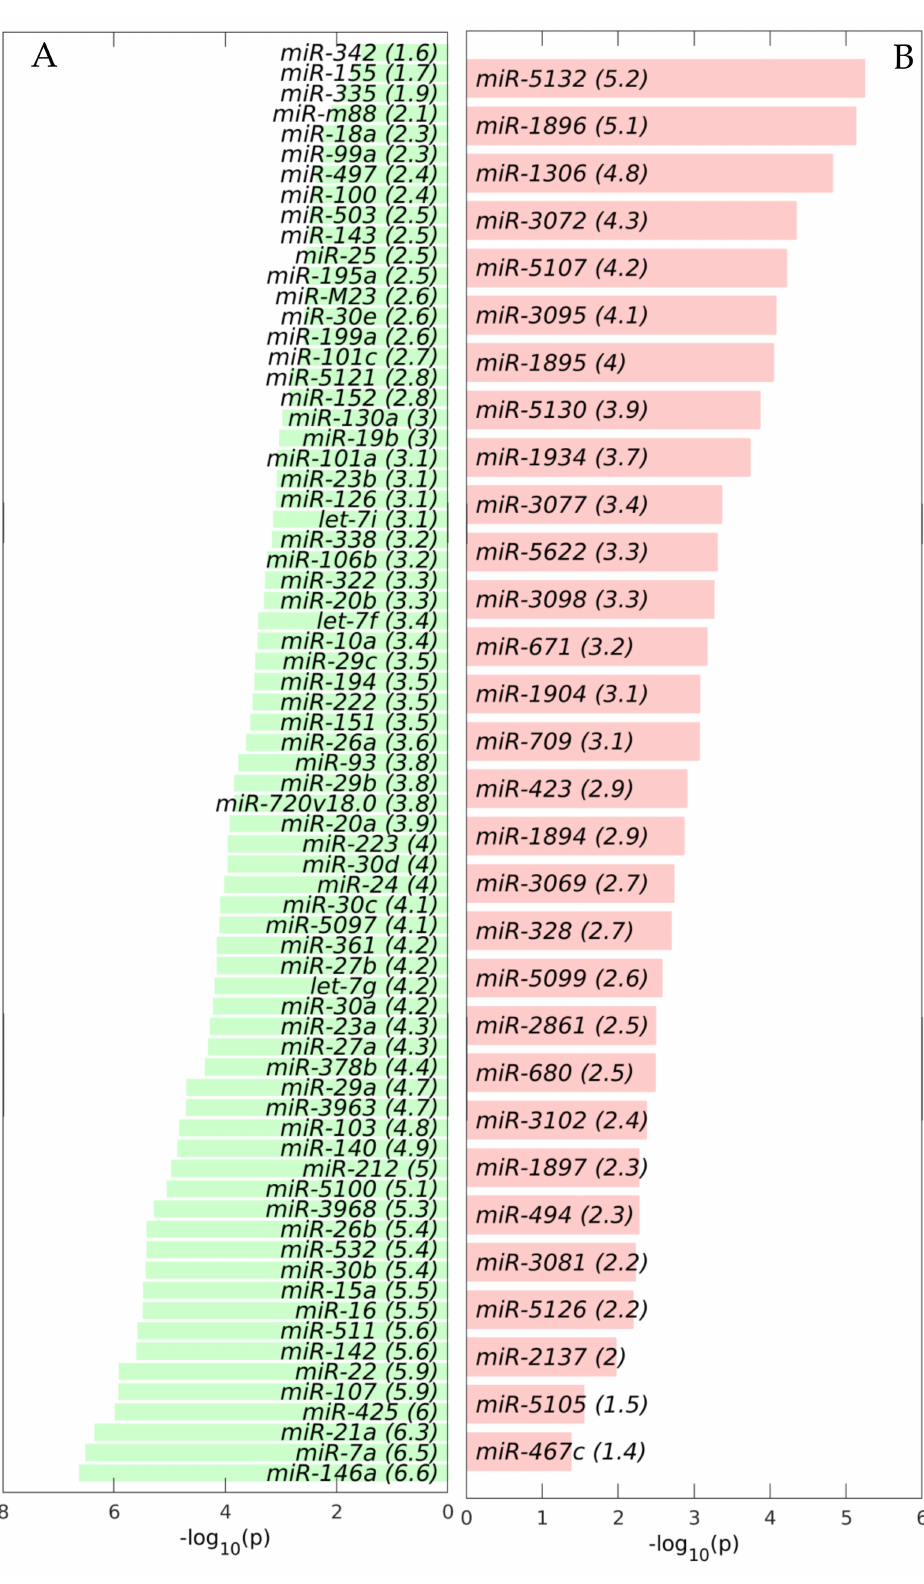
Figure 5. Differentially expressed miRNAs (DEMs) between the control and the tumor microenviron- ment (TME) cells. Bar plots of the − log 10 ( p ) of the statistical significance of the DEMs. ( A ) Downreg- ulated in the TME DEMs. ( B ) Upregulated in the TME